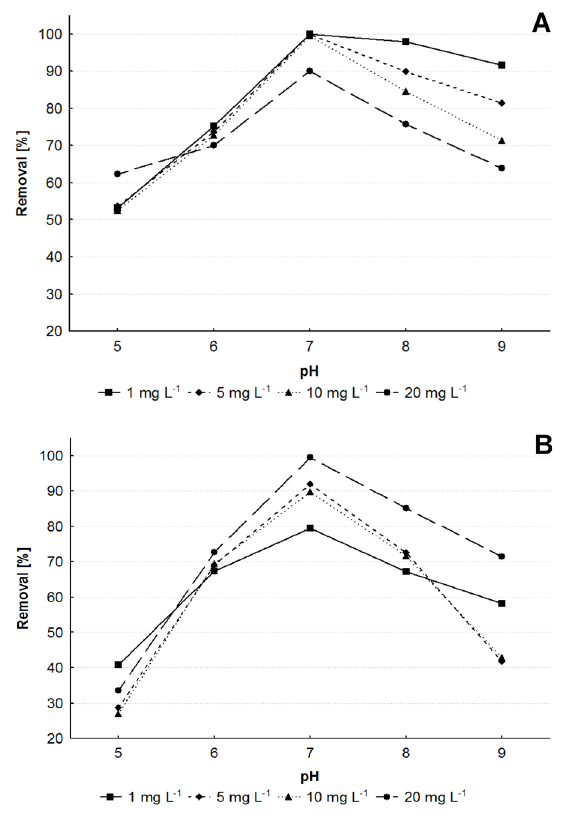
Figure 2. The effect of pH on biosorption of Pb (A) and Cd (B) by M. aeruginosa after 3 h and 6 h of contact,